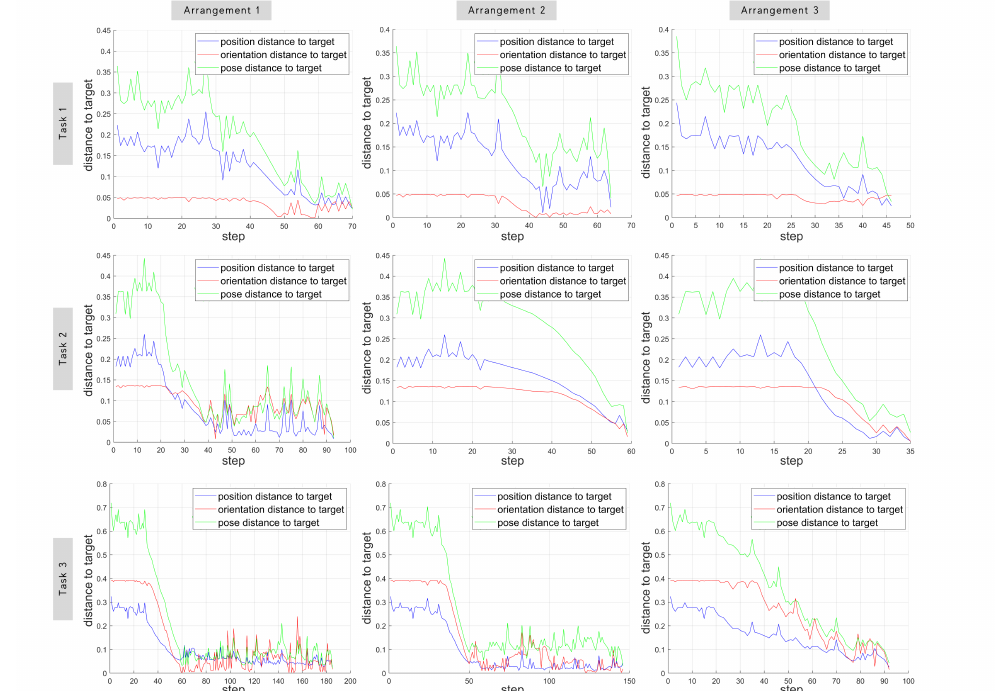
Figure 6. The controller performed three reaching tasks. In all 3 tasks, the controller converged faster when using more control points